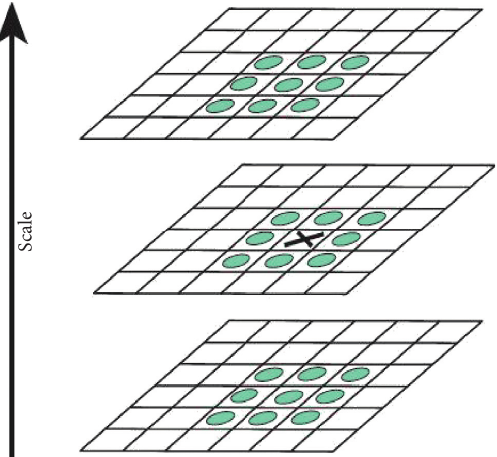
Figure 8: The pixel marked X chosen as a maxima and 26 points in its neighborhood.